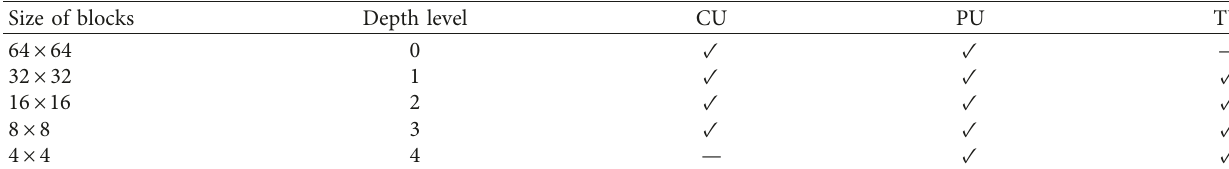
Table 1: Size of the blocks for different unit types.